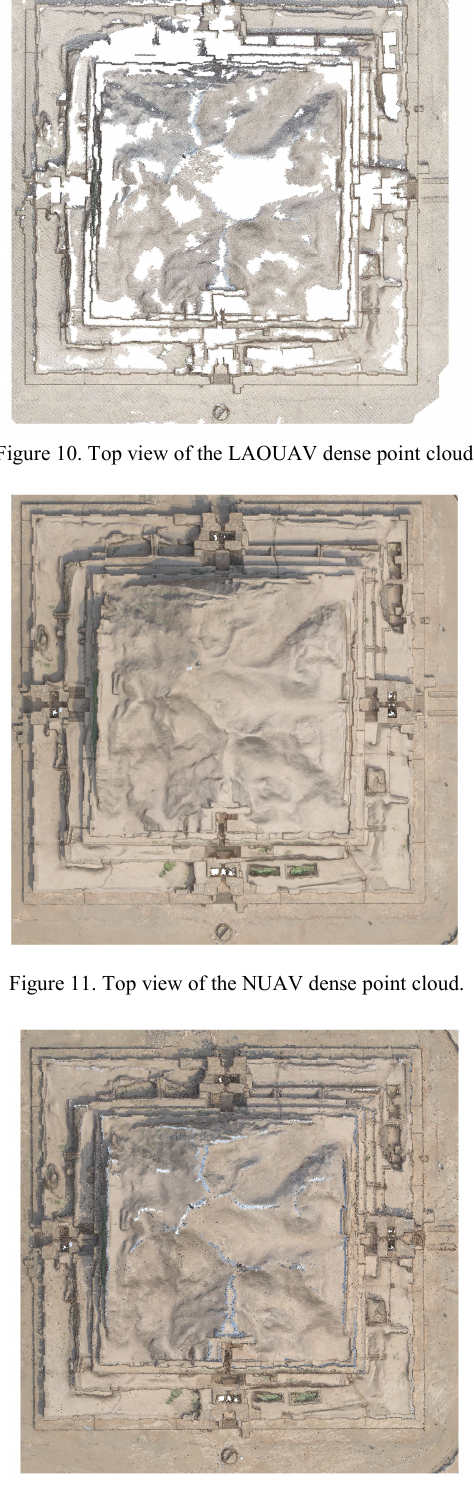
Figure 12. Top view of the merged point